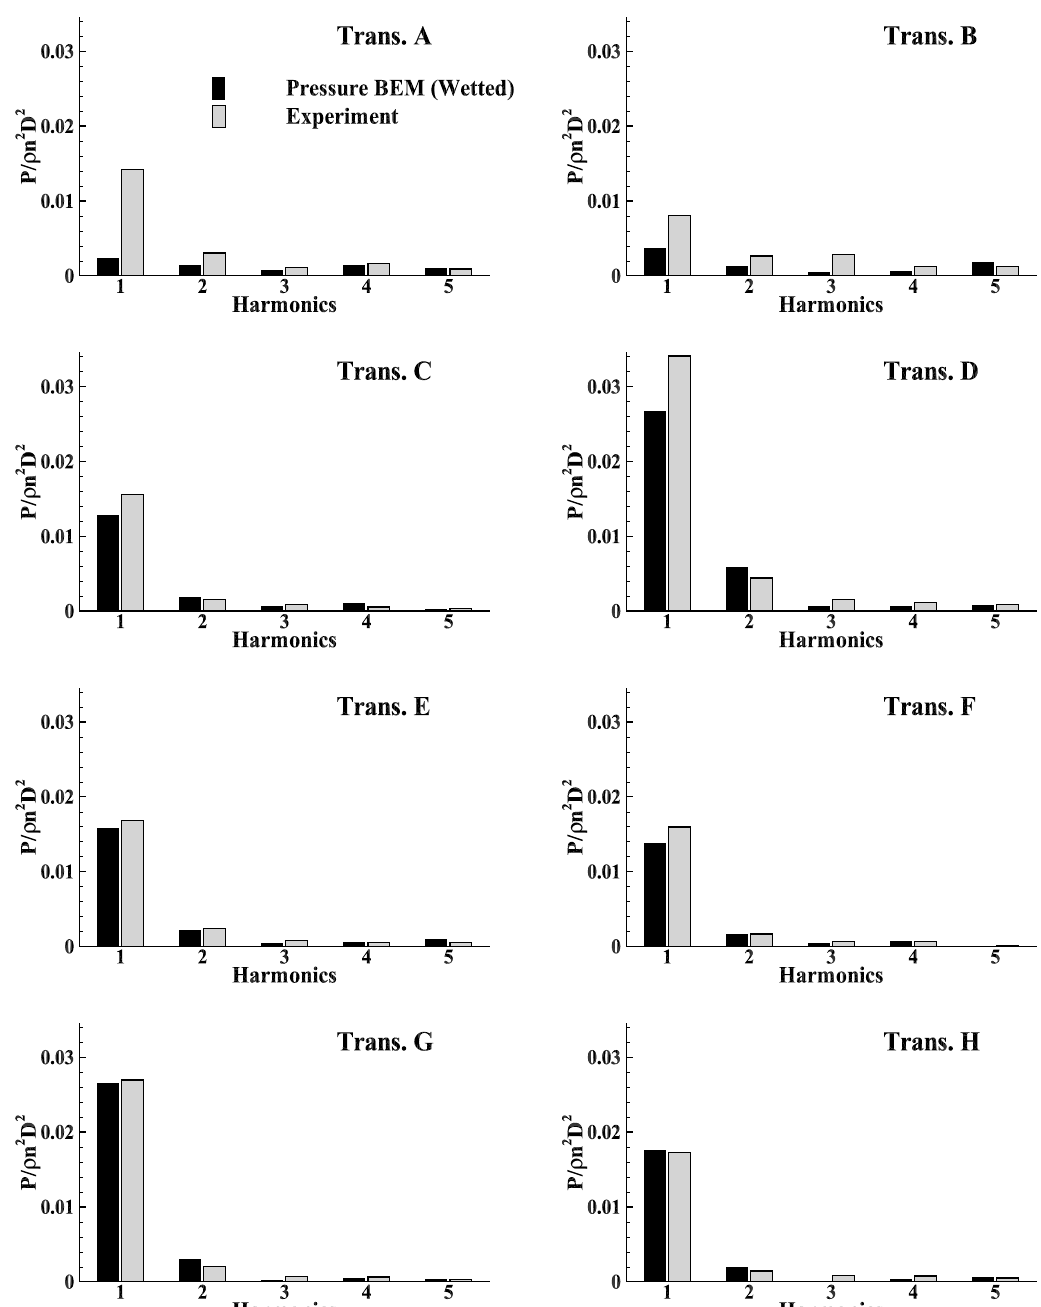
Figure 37. Comparisons of the pressure harmonics predicted by the BEM in fully wetted condition with the measurements